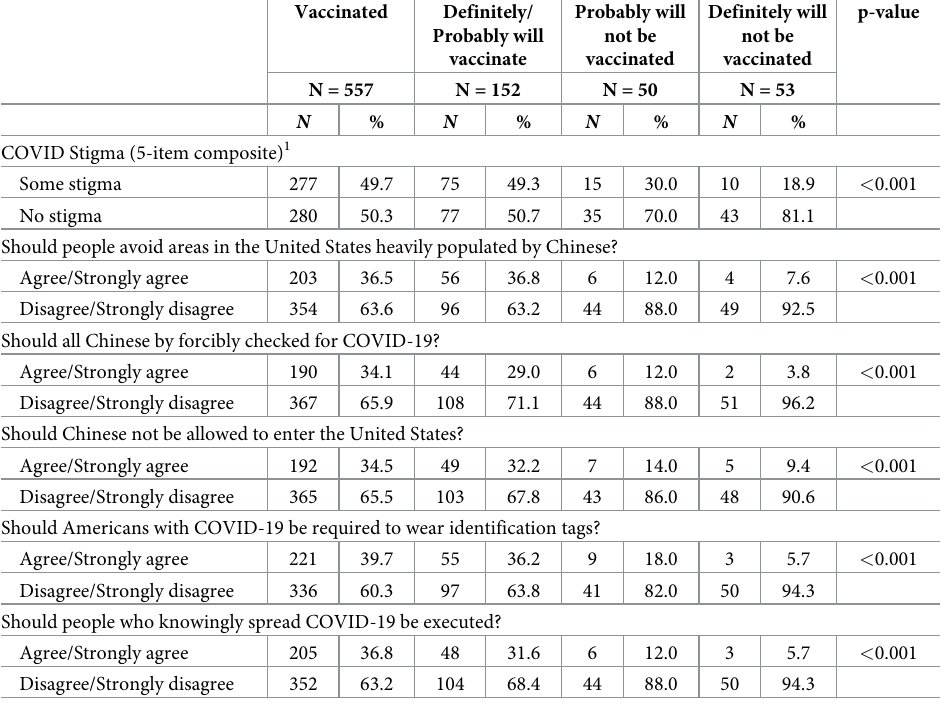
Table 6. SABRs by vaccine intentions for Wave 2, N = 812.